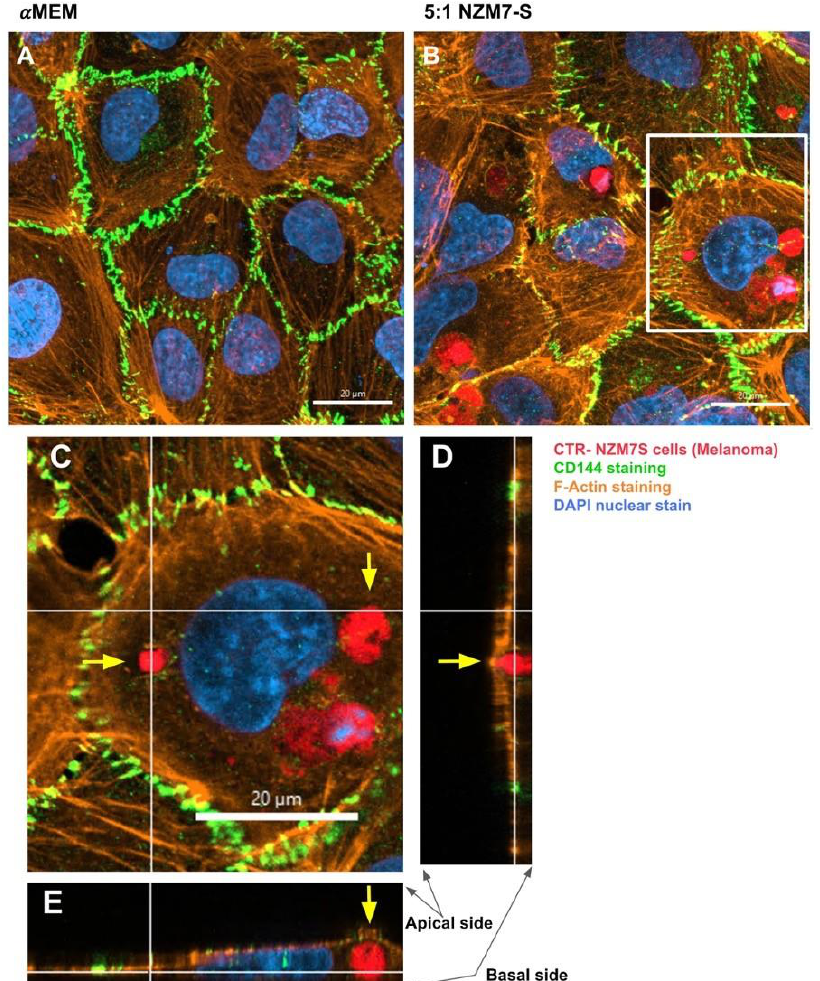
Figure 12. Confocal microscopy Z-stack imaging to localise the position of NZM7-S within cerebral endothelial cells. hCMVECs were seeded at 20,000 cells per well. NZM7-S were live stained with CytoTrack Red (CTR) and applied to the apical face of a confluent endothelial monolayer. Cells were co-cultured for 4 h, washed and then fixed. Junctions were stained with anti-CD144 (green), actin stained with phalloidin (orange) and nuclei stained with Hoechst (blue). Samples were analysed by confocal laser scanning microscopy. ( A ) Untreated hCMVECs. ( B ) NZM7-S added at a 5:1 E:T ratio; the white box is expanded in ( C ). ( C ) The xy-stack at the level of the white lines on ( D , E ). ( D , E ) The z-stacks along the vertical and horizontal line, respectively, on ( C ). Yellow arrows show NZM7-S located within the cerebral endothelial cell body underneath endothelial actin. Images acquired us- ing a Zeiss LSM 800 Airyscan confocal microscope .